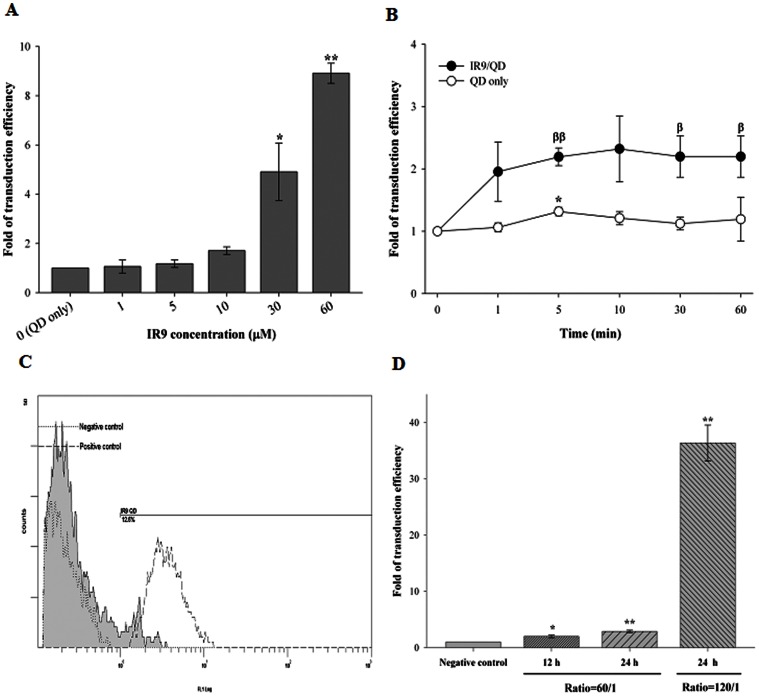
Flow cytometric analysis of cellular internalization of IR9/QD complexes.(A) Concentration-dependent internalization of IR9/QD complexes into cells. Different amounts of IR9 (1, 5, 10, 30 and 60 µM) were mixed with QDs at a molecular ratio of 60. IR9/QD complexes were transferred onto cells and incubated for 1 h. The fluorescent intensity was analyzed using a flow cytometer. Cells treated with QDs alone served as a negative control. Data are presented as mean ± SD from 3 independent experiments in each treatment group. (B) Time-dependent internalization of IR9/QD complexes into cells. Five µM IR9 were mixed with QDs at a molecular ratio of 60 and then incubated with cells for 0 (negative control), 1, 5, 10, 30 and 60 min, as indicated. Data are presented as mean ± SD from 3 independent experiments in each treatment group. (C) Merged flow cytometric plots of cellular internalization of IR9/QD complexes. Cells were treated with IR9/QD complexes prepared at a molecular ratio of 120 at 37°C for 24 h (gray area). Results from the negative control are shown by the dotted line at the left, while results from the positive controls (5 µM of IR9-FITC) are shown by dashed line. (D) Cellular internalization comparison of IR9/QD complexes at different combined ratios. Cells were treated with different molecular ratios (60 and 120) of IR9/QD complexes for the indicated periods of time (12 and 24 h). Significant differences of P<0.05 (*, β) and P<0.01 (**, ββ) are indicated. Data are presented as mean ± SD from 3 independent experiments in each treatment group.